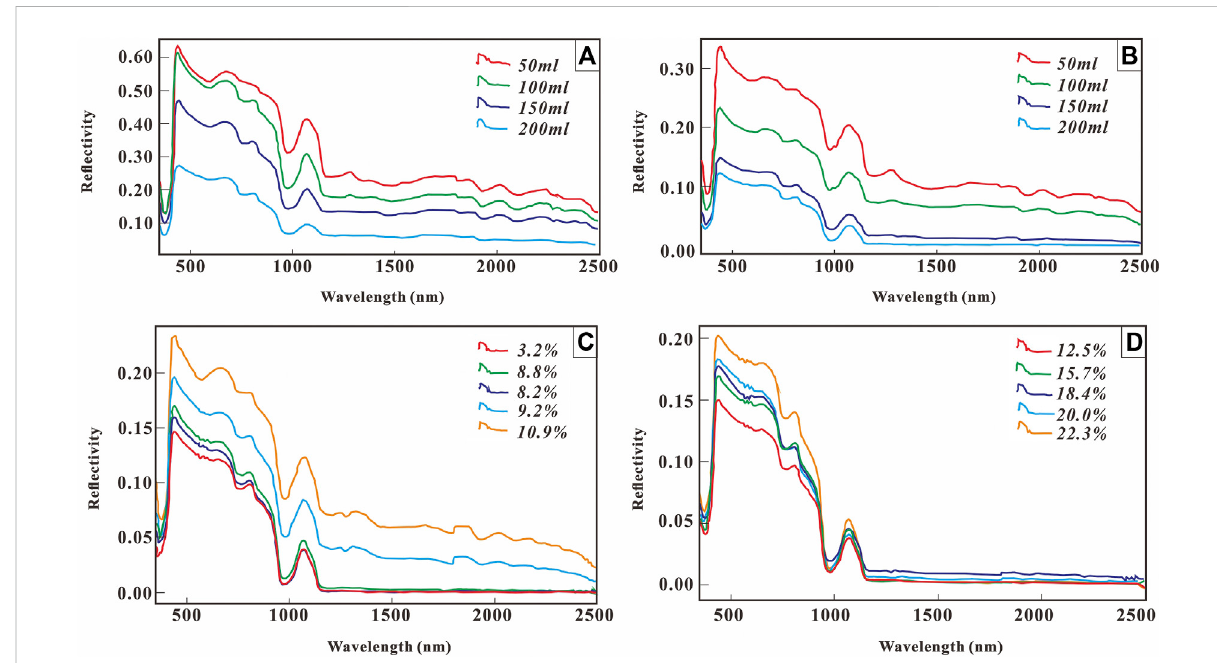
FIGURE 3 Spectral measurement results of the water with different depths and salinities. (A) Measured spectra of water at different depths in the North Lake; (B) Measured spectra of water at different depths in the South Lake; (C) Measured spectra of water at different salinities in the North Lake; (D) Measured spectra of water at different salinities in the South Lake.